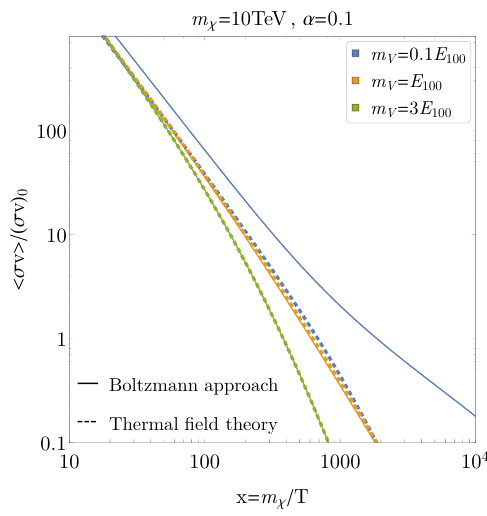
Figure 6 . Comparison of the thermally averaged bound-state formation cross section for bath- particle scattering in the conventional Boltzmann and the thermal (cid:12)eld theory